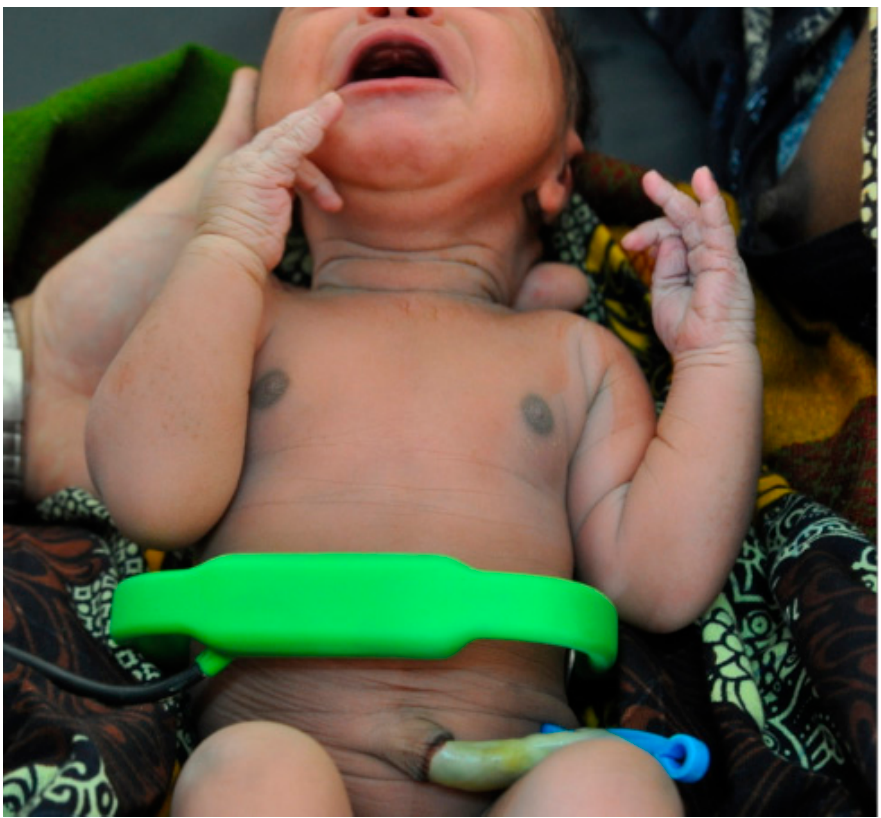
Figure 1. The dry ‐ electrode ECG sensor used in this study. Figure 1. The dry-electrode ECG sensor used in this study.